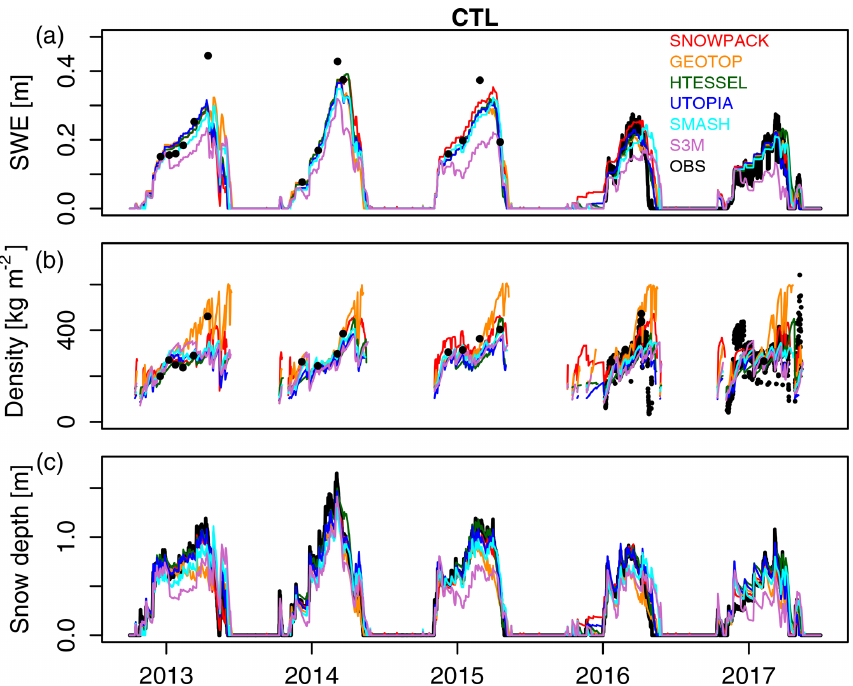
Figure 1. Results of the CTL experiment: (a) snow water equivalent (SWE), (b) snow density and (c) snow depth simulated by the six models considered in the analysis, driven by optimal forcing, i.e. Torgnon station measurements at 30min resolution, over the period 2012–2017, compared to observations